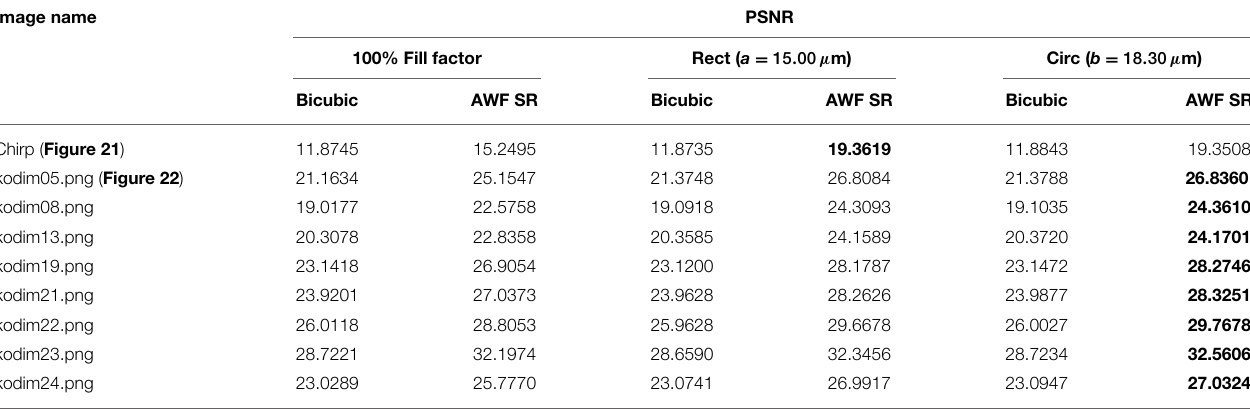
TABLE 2 | PSNR results for AWF SR with K = 16 frames and L = 4 using a variety of 8 bit test images with a simulated MWIR imaging system with Q = 0 . 50 from Table